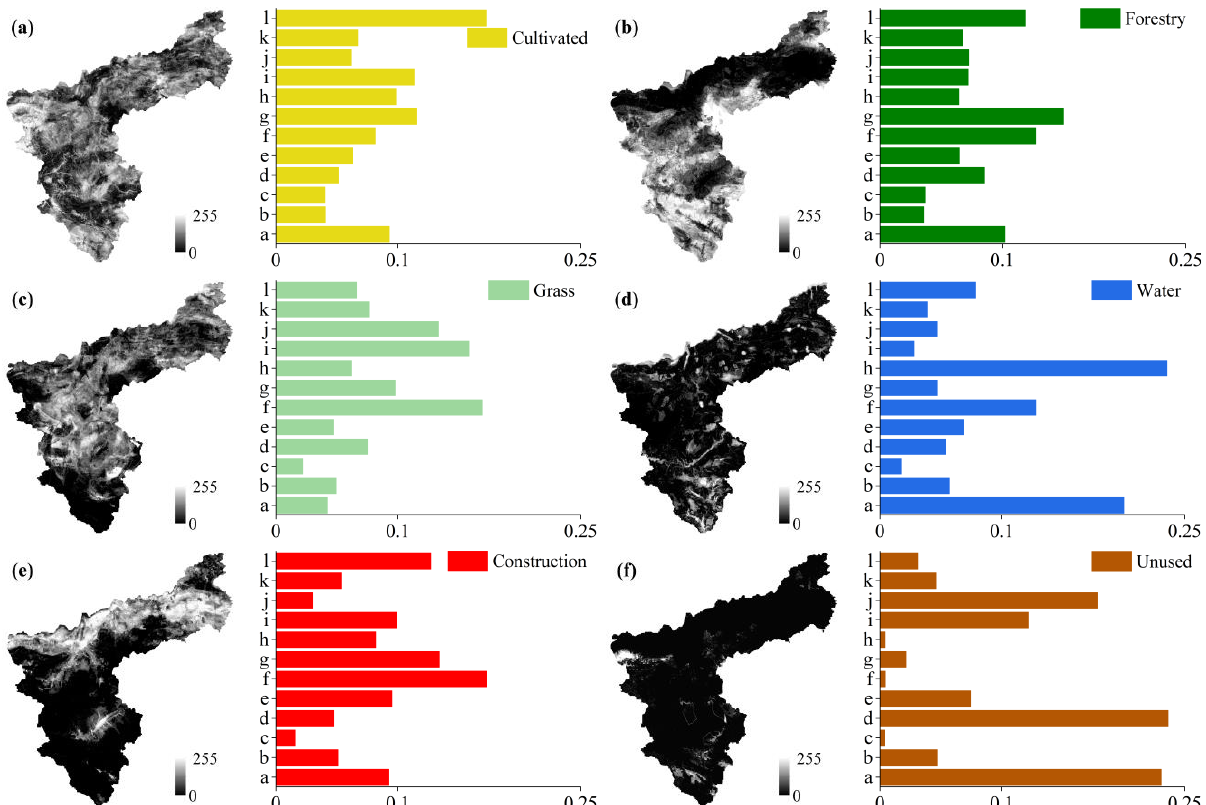
Figure 4. The weights of different drivers in influencing the change in land use (( a ). band 1, cultivated; ( b ). band 2, forest; ( c ). band 3, grass; ( d ). band 4, water; ( e ). band 5, construction land; ( f ). band 6, unused).